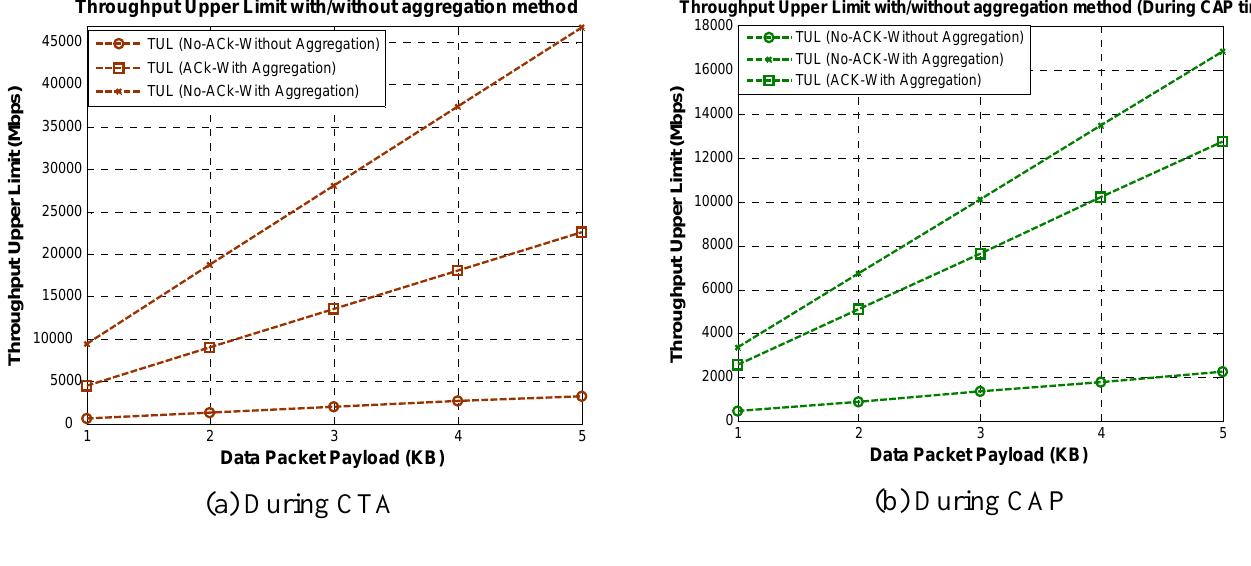
Figure 8. Throughput upper limit versus payload size during CTA and